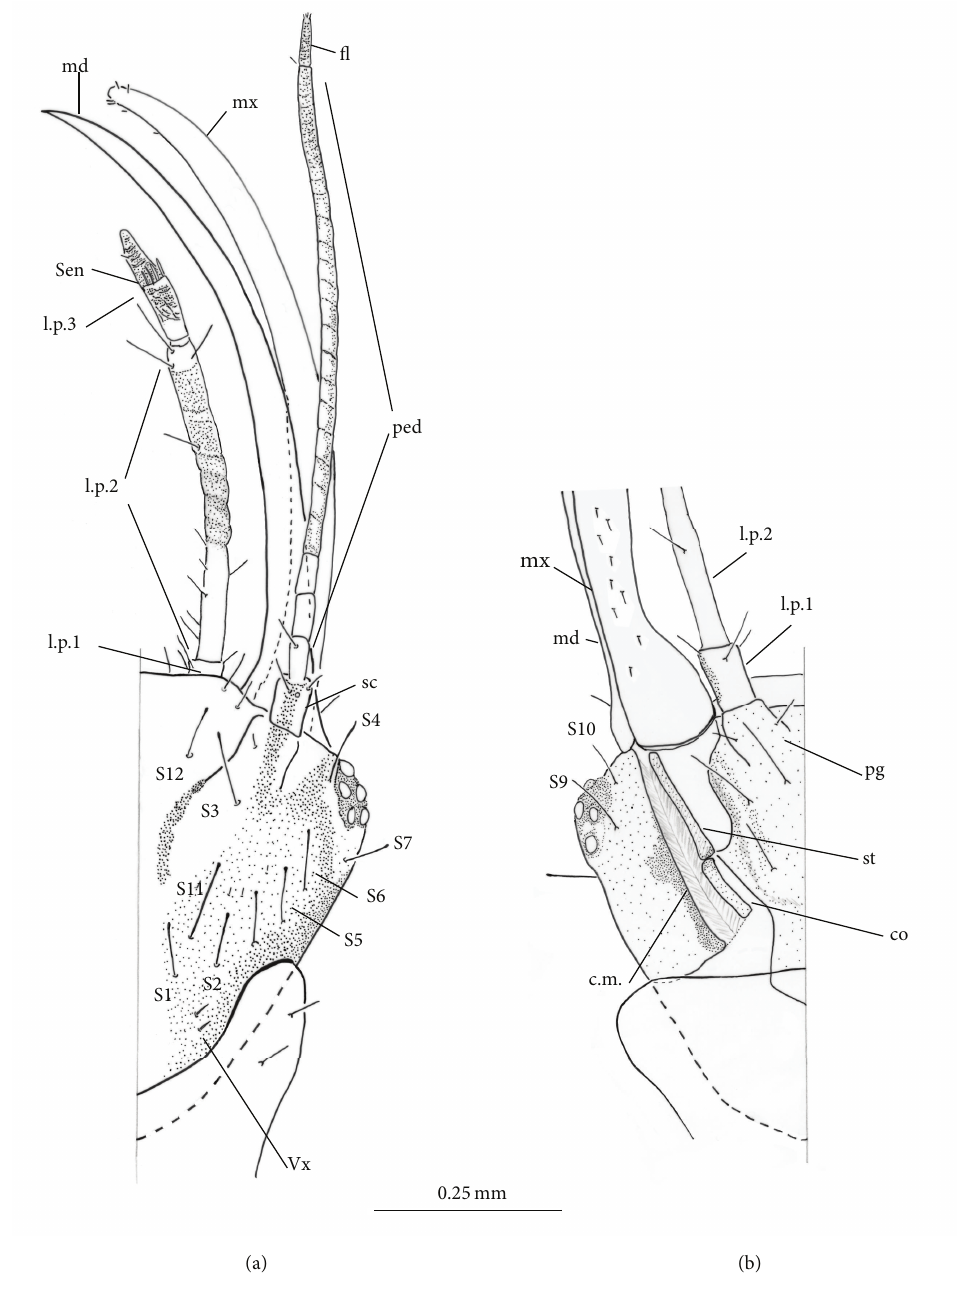
Figure 2: Head of Hypochrysa africana Kimmins, second instar. (a) Dorsal. (b) Ventral. Scale applies to both (a) and (b). Abbreviations: co, cardo; c.m., cranial margin; fl, flagellum; l.p.x, labial palpus, number of segment; md, mandible; mx, maxilla; ped, pedicel; pg, palpiger; sc, scape; sen, sensilla; stp, stipes; Sx, primary seta, number; Vx, Vx setae.